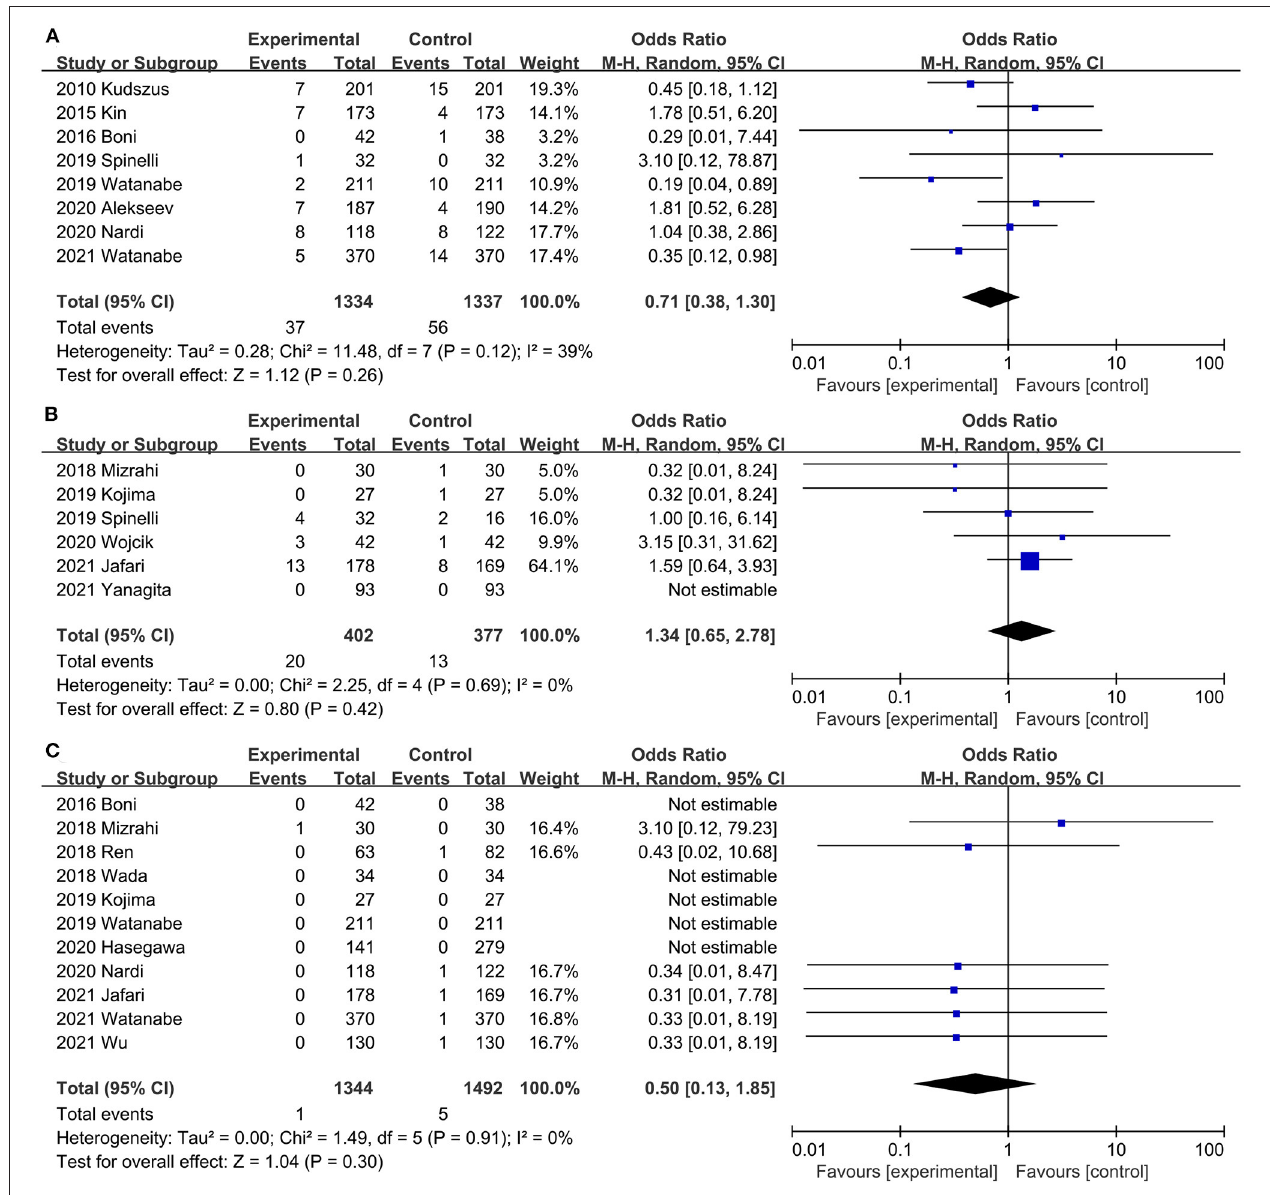
FIGURE 8 | Effect of indocyanine green on (A) Reoperation rate rate. (B) Conversion rate (C)